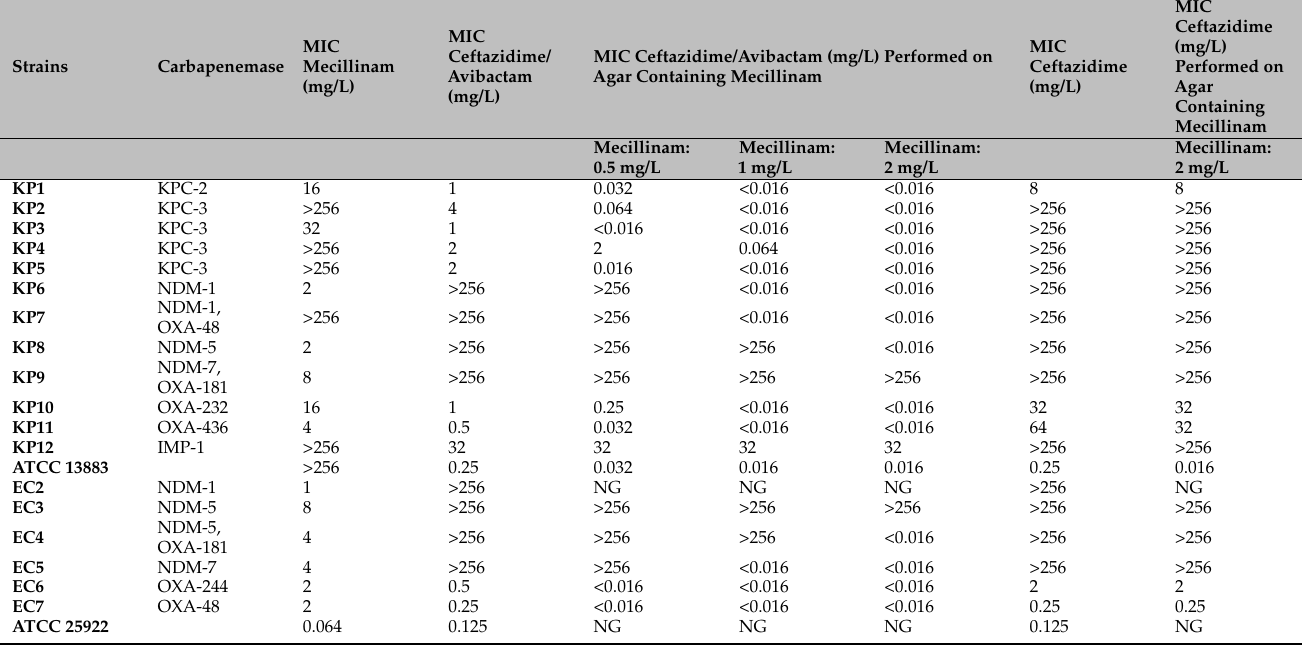
Table 1. Susceptibility patterns of the included isolates as well as results of synergistic tests of mecillinam combined with ceftazidime/avibactam.